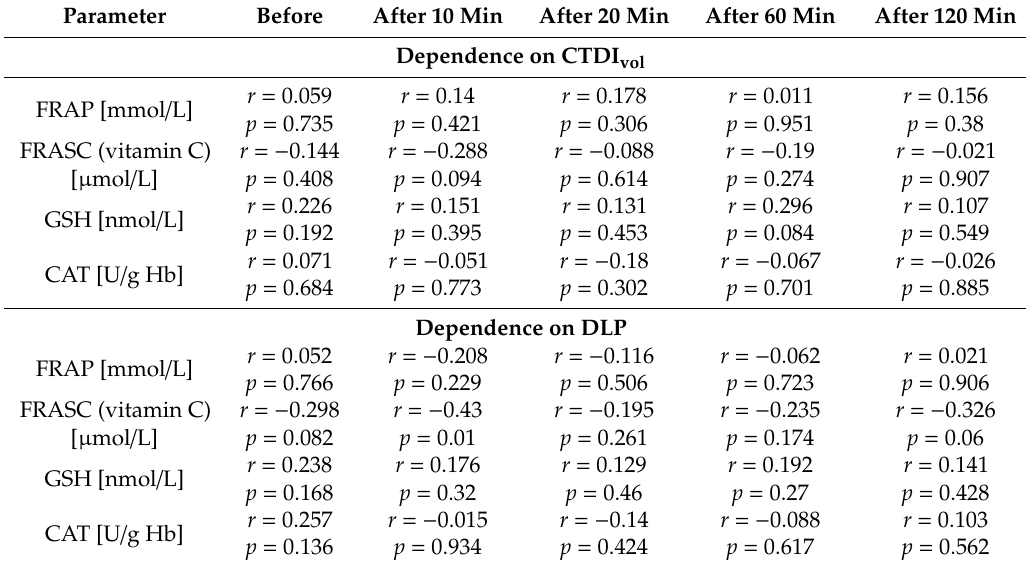
Table 7. The e ff ect of CTDI vol and DLP radiation doses on the values of selected antioxidant parameters (CAT, GSH, FRAP and FRASC) of patients undergoing routine HRCT examination: before the test, and 10, 20, 60 and 120 min after the